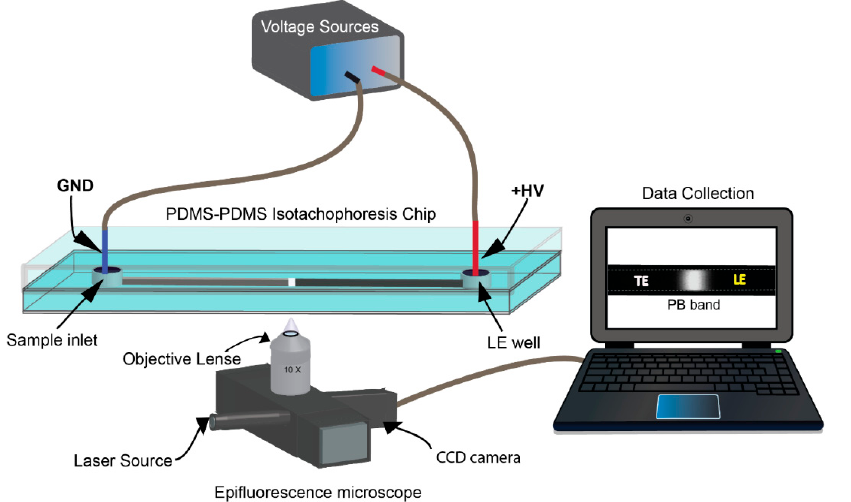
Figure 1. Schematic representation of the experimental setup in which Isotachophoresis (ITP) was used to preconcentrate Pacific blue succinimidyl ester dye (PB) using a simple PDMS microfluidic chip. ITP was performed using a computer-controlled voltage source after filling the sample inlet and